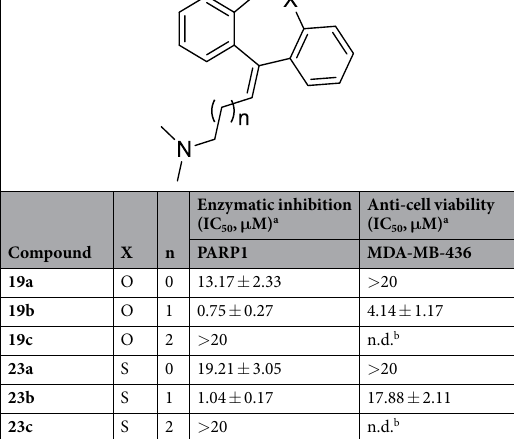
Table 4. Inhibition Data of compounds 19 and 23 against Recombinant Human PARP1 and MDA-MB-436 cells. a The IC 50 values are presented as mean ± SD, which is determined by at least three independent experiments. b The n.d. means data are not determined.